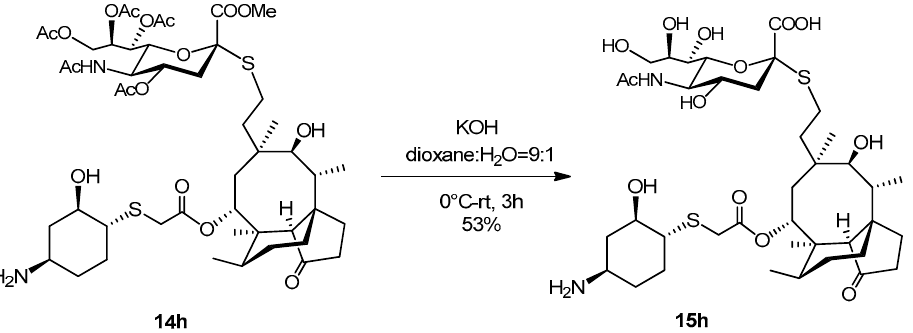
Table 1. Antibacterial effect of semisynthetic pleuromutilins based on Minimal Inhibitory Concen- tration [28] of active compounds (MIC: mg/L) (ATCC: American Type Culture Collection, MRSA/MSSA: methicillin resistant/sensitive S. aureus , VanA and VanB: vancomycin resistant phenotypes.) Bacterial Strains